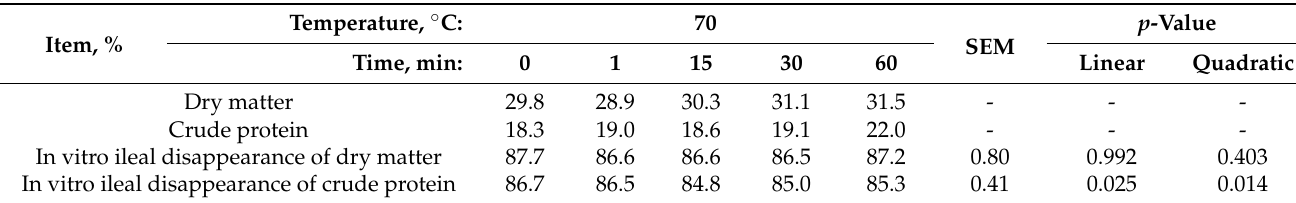
Table 1. Dry matter and crude protein concentrations in chicken meat thermally processed at 70 ◦ C (as-is basis) using water bath and the effects of heating time on in vitro ileal disappearance of dry matter and crude protein of chicken meat thermally processed at 70 ◦ C (Exp. 1) 1 .